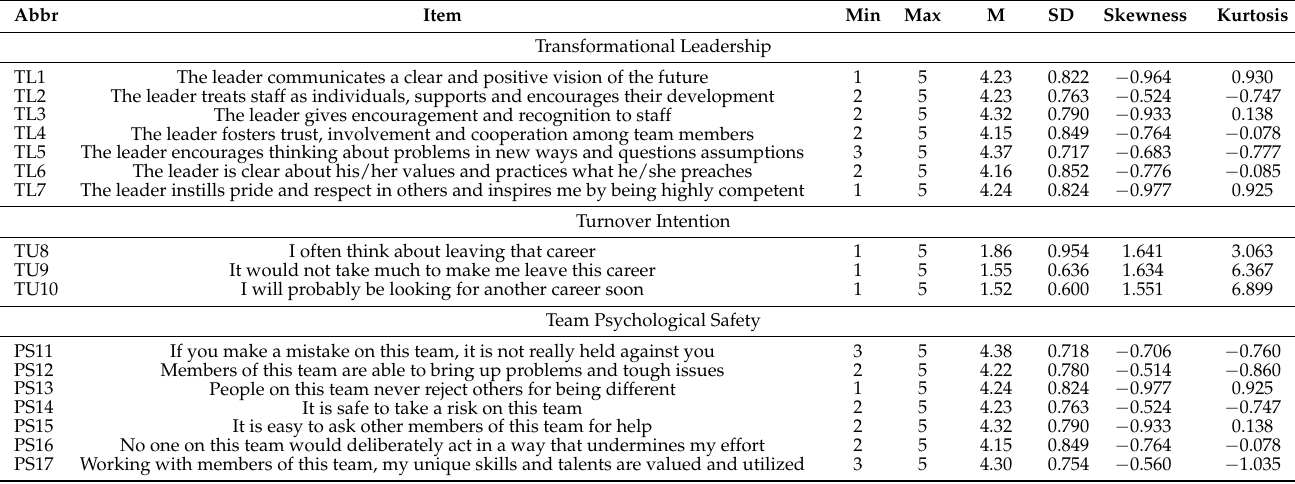
Table 1. The descriptive statistics of the constructs (developed by